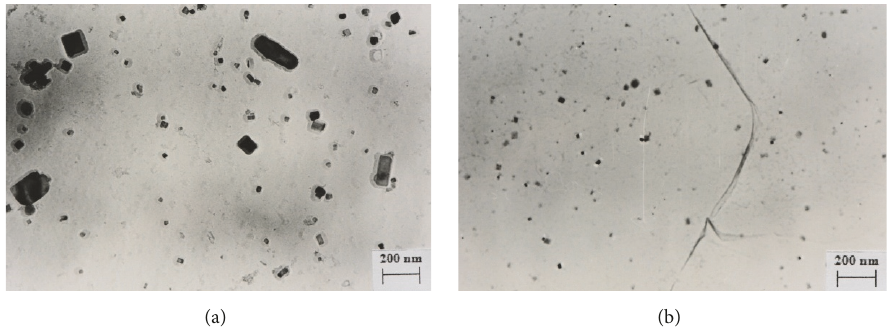
Figure 10: Substructure of (a) H300LAD and (b)